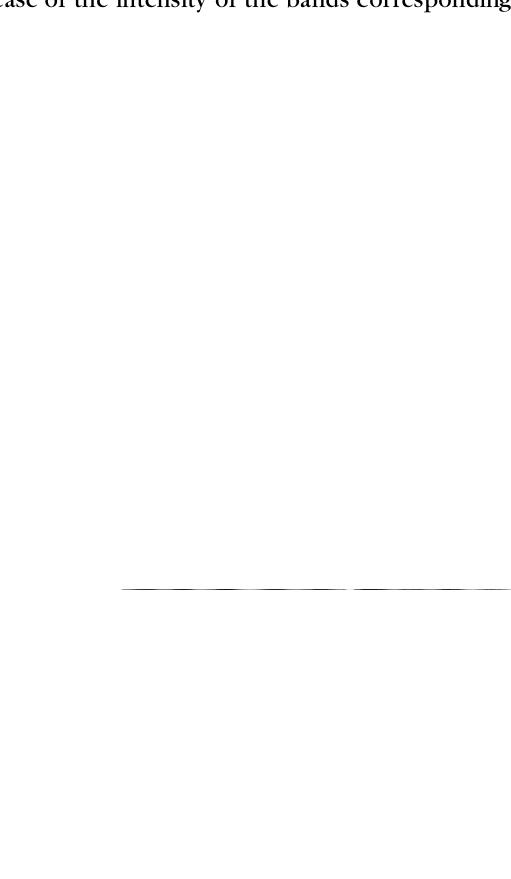
FIG. 4. Effect of DPI on IL-1-induced NF- k B activation. Chondrocyte cultures were pretreated with the indicated concentrations of DPI for 2h before the addition of IL-1 (20ng/ml) for 30min. The nuclear extracts, prepared as described in Materials and methods, were used to detect NF- k B binding to a specific oligonucleotide probe by EMSA. The results shown are representative of three independent experiments.